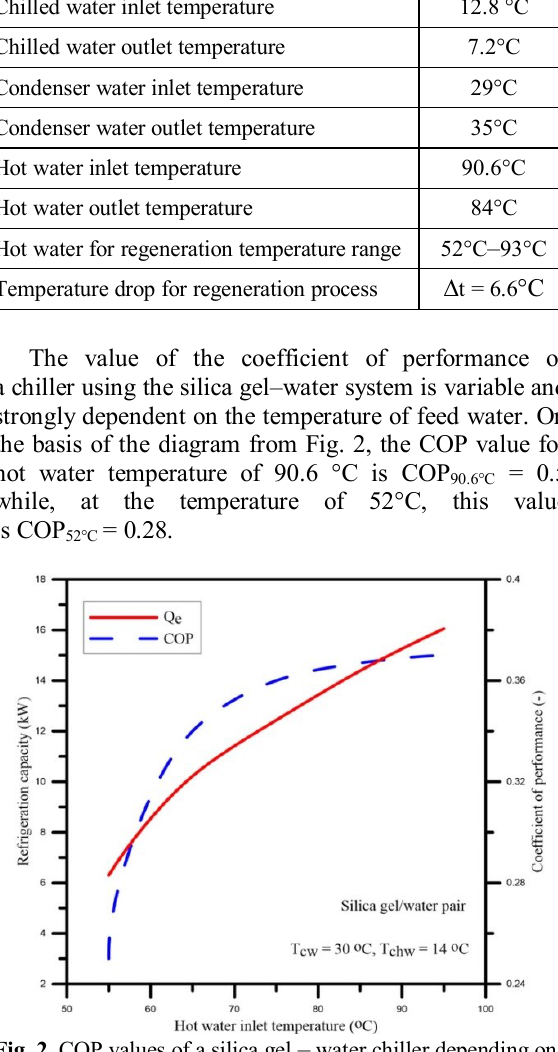
Fig. 2. COP values of a silica gel – water chiller depending on the temperature of feed water